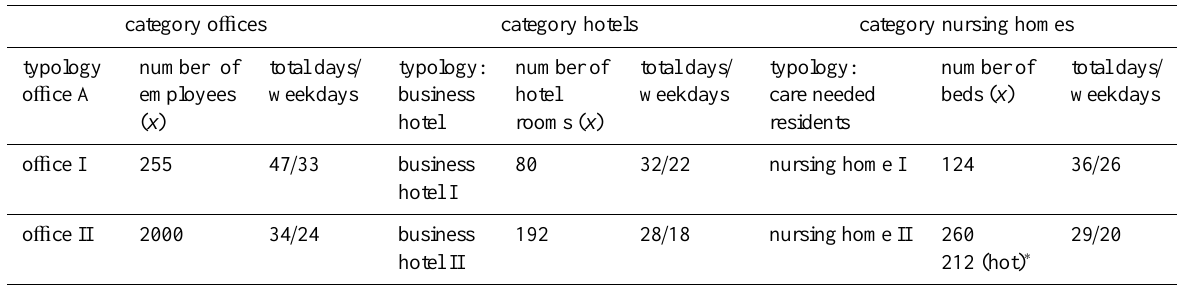
Table 6. Selected buildings for measurement of cold and hot water demand and the number of measured days and weekdays, to validate the developed design-demand-equations for o ffi ces, hotels and nursing